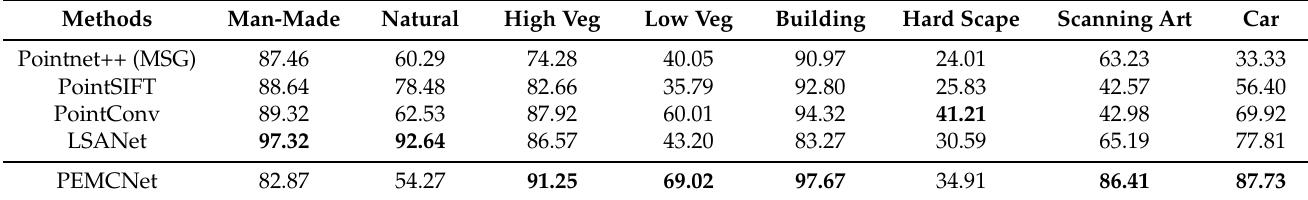
Table 4. Classification accuracy of each class of different networks on Semantic3D (reduced-8) dataset in terms of IoU (%).